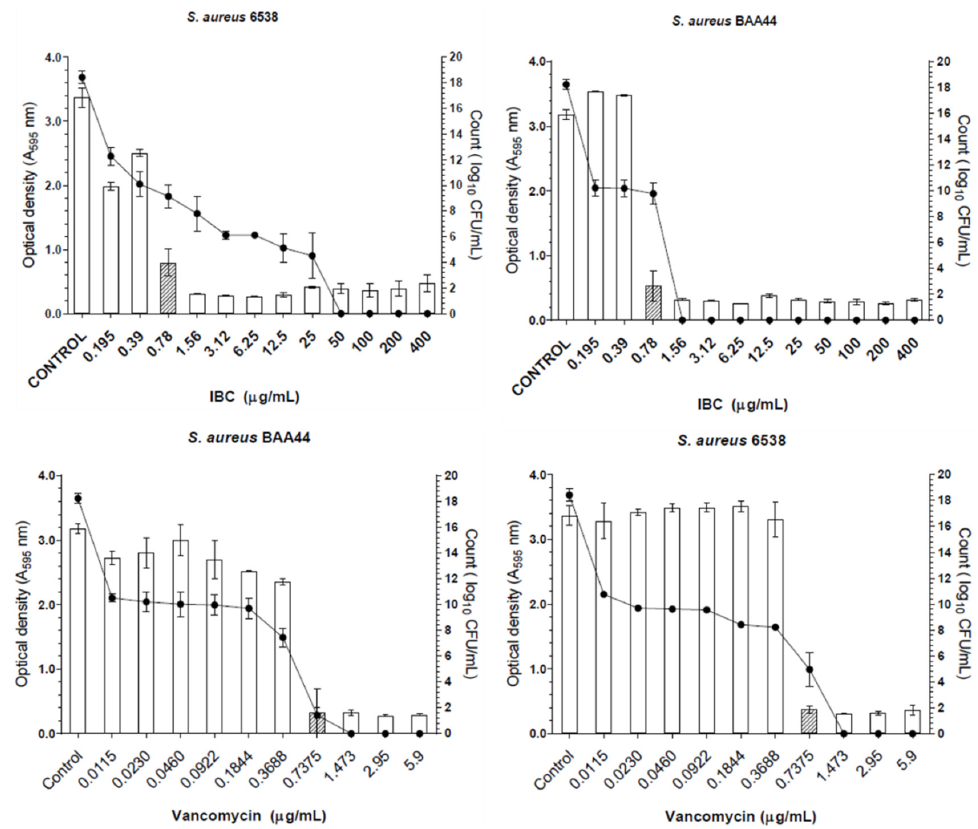
Figure 2. Effect of IBC and vancomycin on MSSA ( S. aureus 6538) and MRSA ( S. aureus BAA44) biofilm formation. The hatched bars represent the MBIC values. The lines represent the log 10